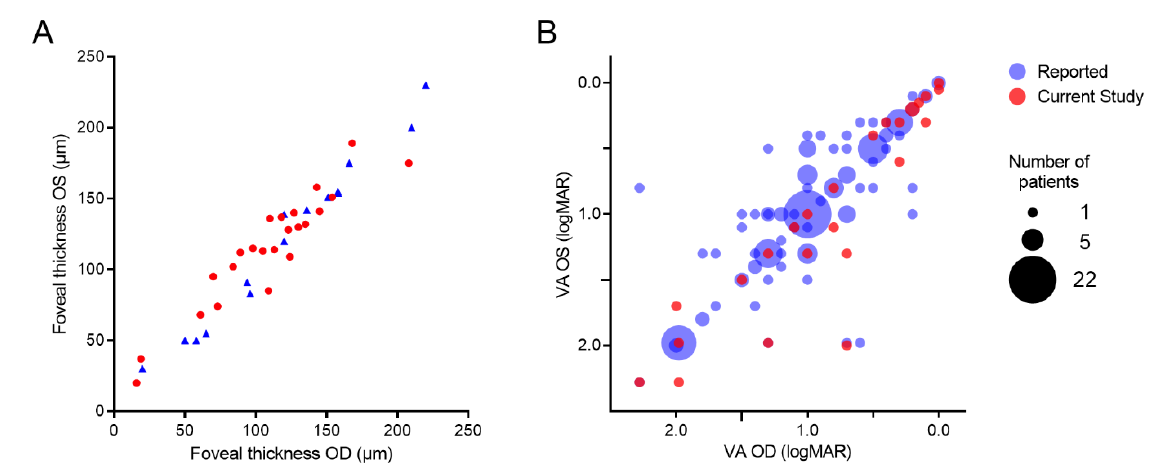
Figure 3. Analysis of symmetry between OD and OS. ( A ) High symmetry of foveal thickness in n = 38 patients (Spearman’s rho = 0.96). ( B ) High symmetry of visual acuity in n = 165 patients (Spearman’s rho = 0.85).